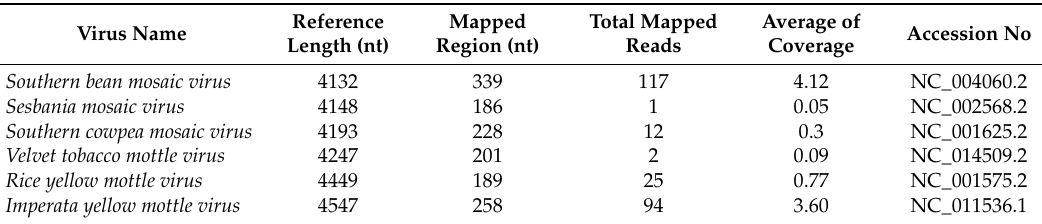
Table 1. Virus ‐ like sequence reads mapped with the species of the genus Sobemovirus in next ‐ generation sequencing (NGS) sequence date of Blueberry shoestring virus (BSSV) grafted blueberry seedling.